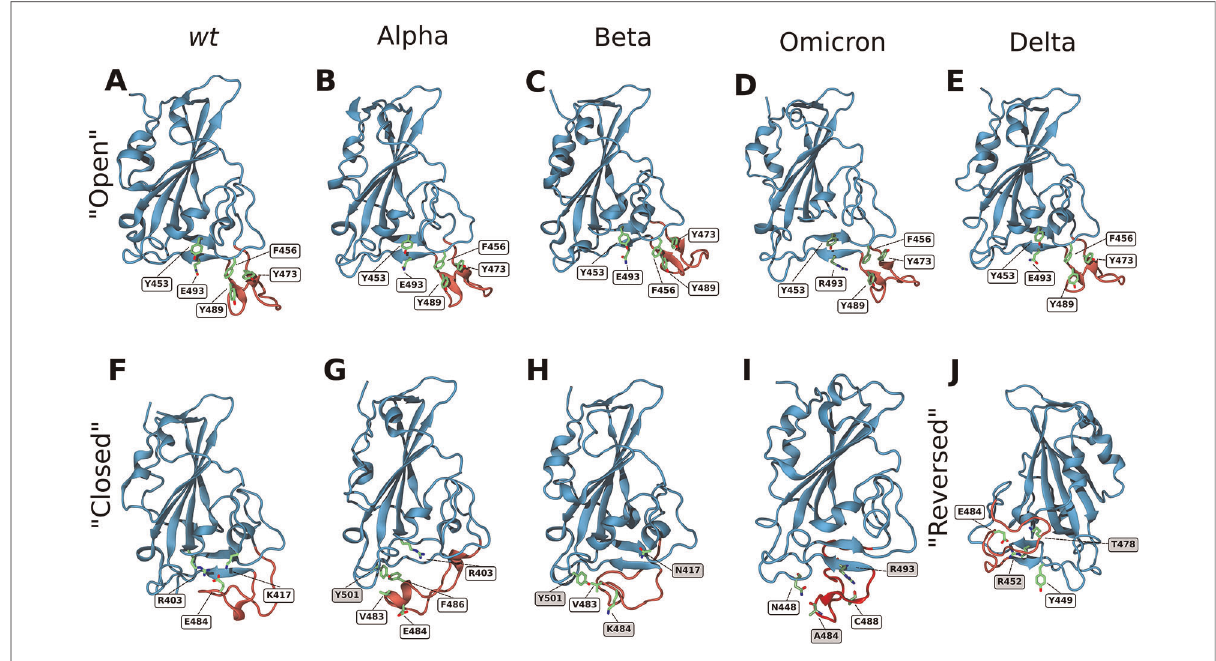
FIGURE 3 Closeup snapshots of SARS-CoV-2 RBD intramolecular interactions that stabilize the various conformations. Snapshots from AA MD simulations showcasing crucial intramolecular interactions responsible for stabilizing the open, closed, and reversed conformations for the wt ( A,F ), Alpha ( B, G ), Beta ( C,H ), Omicron ( D,I ) and Delta ( E,J ) RBD variants. The ridge region of the RBD is colored in red and residues of interest in green. Text labels indicate relevant residues, with shaded labels indicating mutations relative to wt . All fi gures are rotated 180° relative to Figures 1 , 2 , apart from snapshot